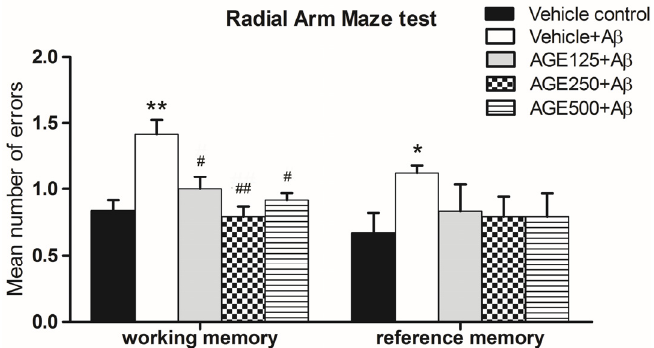
Figure 3. Number of working memory errors and reference memory errors made while looking for the baited arm in the RAM on day 6 after A β injection. Data are presented as mean ± S.E.M. ( n = 8), *, ** = significant differences from the vehicle control group at p < 0.05 and 0.01, respectively; # , ## = significant differences from the vehicle + A β group at p < 0.05 and 0.01, respectively.